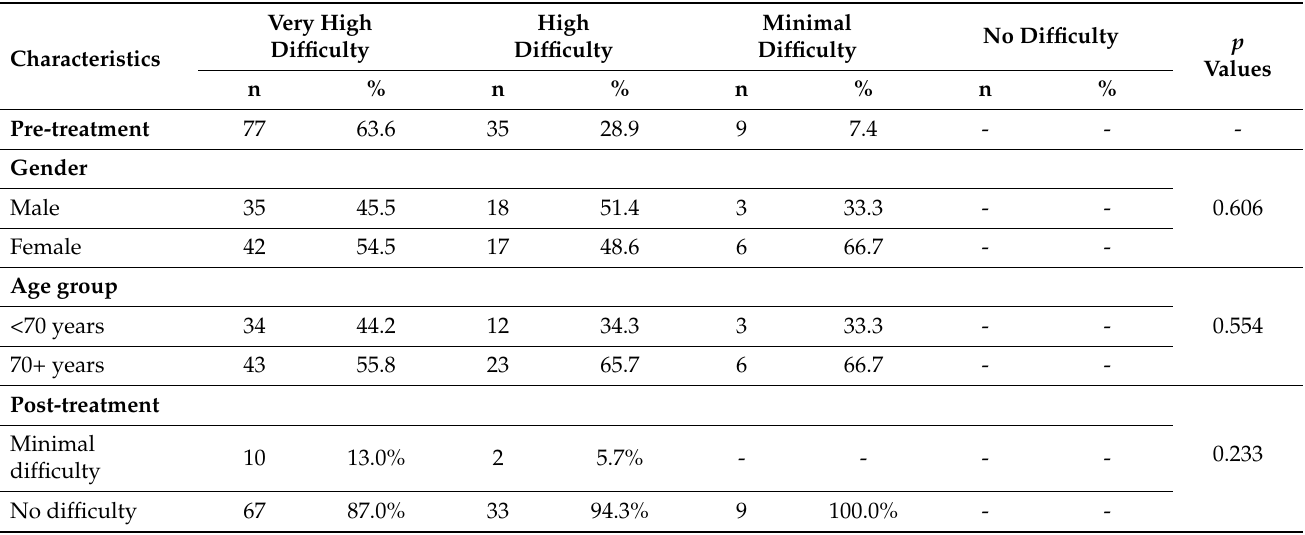
Table 7. The percentage distribution of patients with reading difficulties of a text on TV according to pre- and post-treatment study group characteristics .